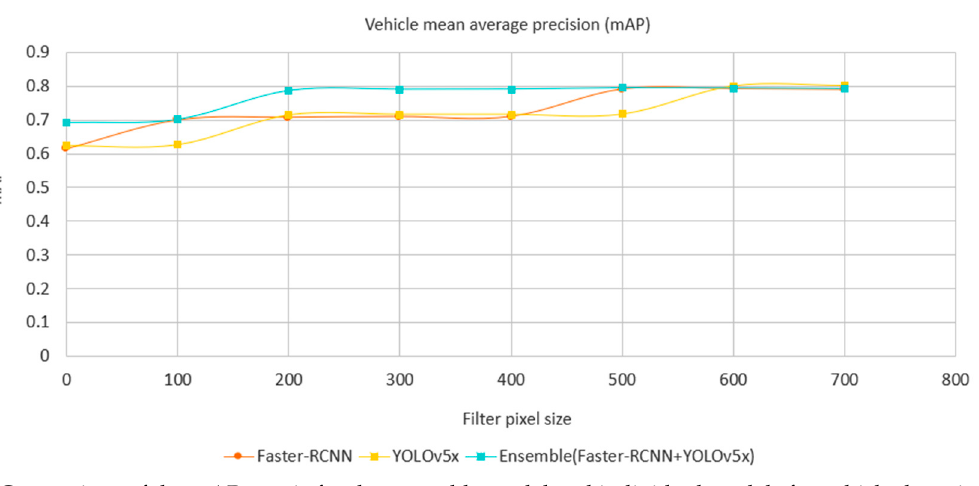
( a ) Comparison of the mAP metric for the ensemble model and individual models for vehicle detection.